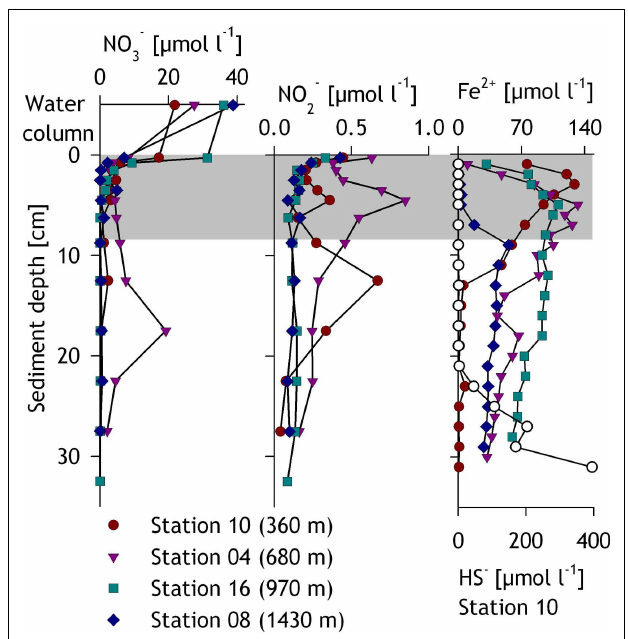
the investigated stations. The gray zone indicates the layers sampled for slurry incubations and DNA extraction, while the zone immediately above in the first panel represents the water column or bottom water. Samples for nitrate concentrations in the bottom water were retrieved from the bottom-most CTD sample. Sulfide was only measurable at and thus shown for station